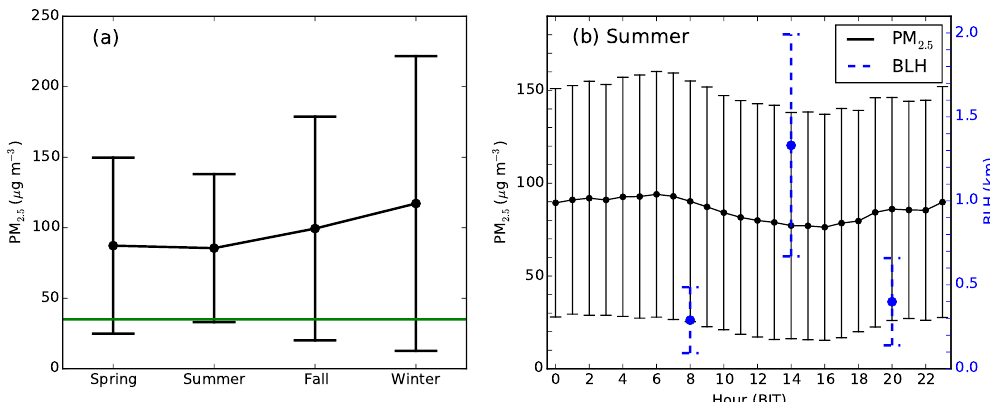
Figure 3. (a) Seasonal variation of the daily averaged PM 2 . 5 concentration (the mean ± 1 standard deviation), and (b) diurnal cycle of the PM 2 . 5 concentration (the mean ± 1 standard deviation) in summer derived from hourly measurements made at the US Embassy air quality station from 2011 to 2014. The green line in (a) shows the national standard level (35µgm − 3 ) . The diurnal cycle of the BLH (in blue, the mean ± 1 standard deviation) derived from summertime soundings in Beijing is shown in (b) on the right-hand ordinate.